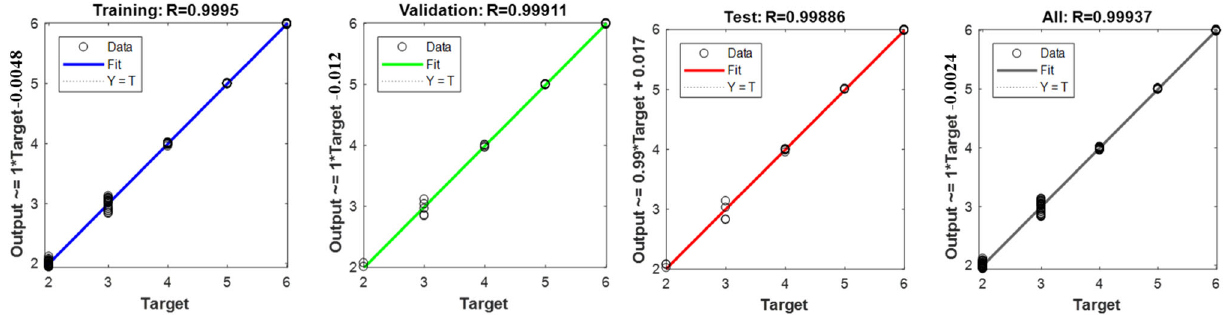
Figure 7. SBS content Regression model results of L ‐ M algorithm with seven hidden neurons.